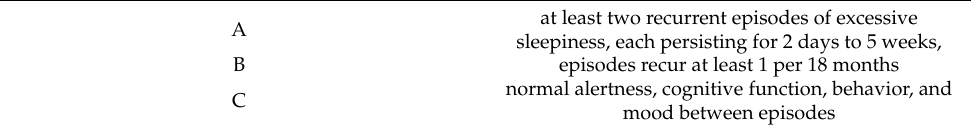
Table 1. Diagnostic criteria for Kleine-Levin syndrome